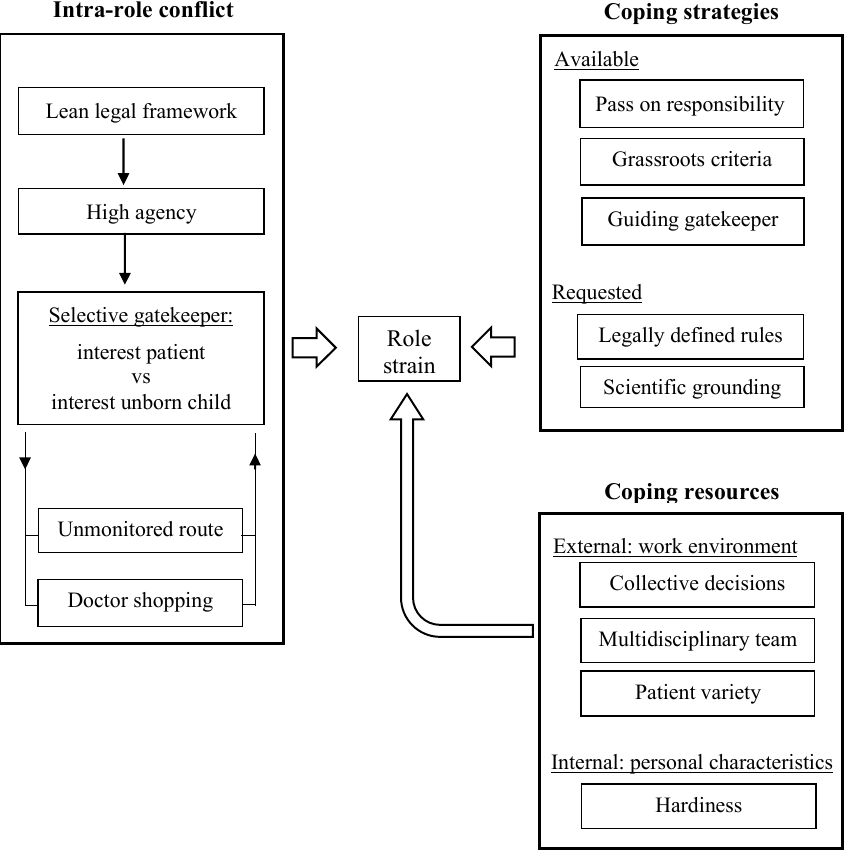
Figure 1. The coding scheme of coping with role strain from the intra-role conflict during decision making.